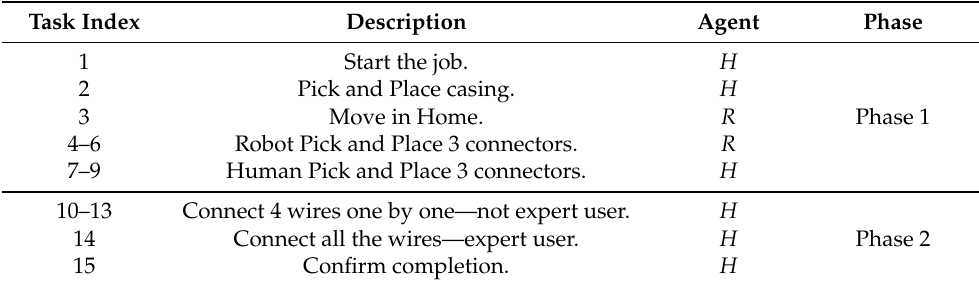
Figure 5. AND/OR graphs representing all the experiments performed. ( a ) Representation of the first three scenarios; ( b ) representation of the parallel work. Table 1. Tasks description of AND/OR graph in Figure